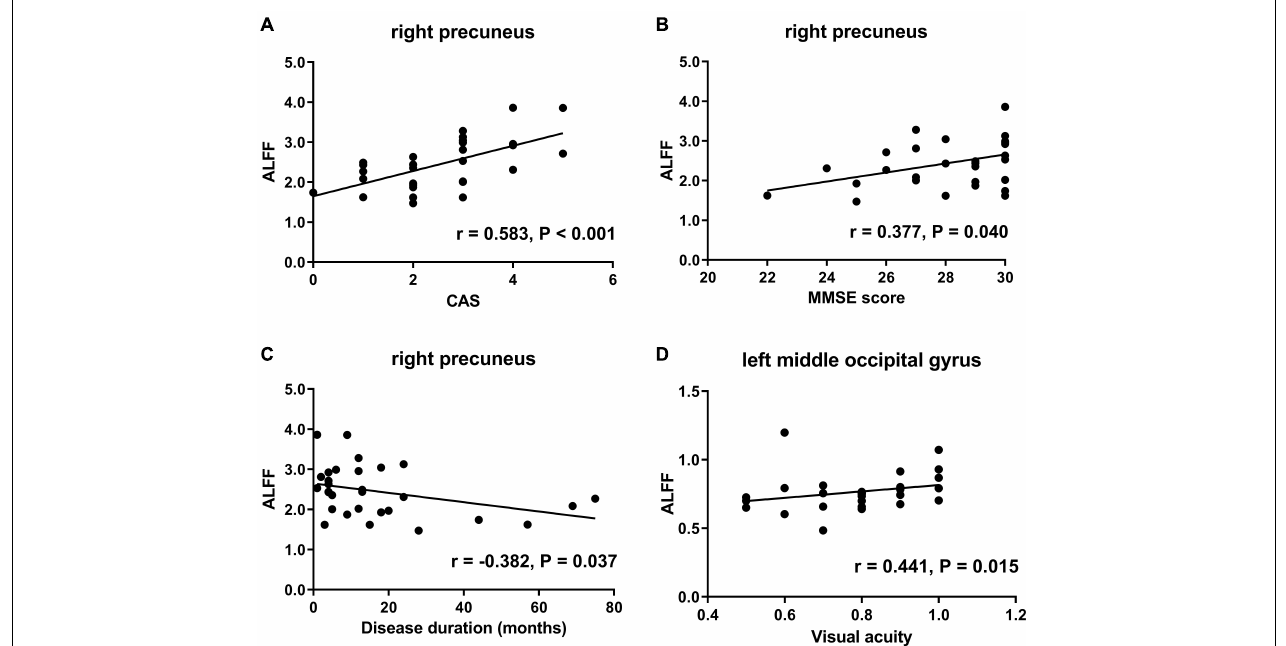
FIGURE 5 | Scatter diagrams show the significant correlations between clinical and neuropsychological assessment results and the ALFF values in TAO patients. (A) ALFF in the right precuneus was positively correlated with CAS ( r = 0.583, P < 0.001). (B) ALFF in the right precuneus was positively correlated with MMSE score ( r = 0.377, P = 0.040). (C) ALFF in the right precuneus was negatively correlated with disease duration ( r = − 0.382, P = 0.037). (D) ALFF in the left middle occipital gyrus was positively correlated with visual acuity ( r = 0.441, P = 0.015). ALFF, amplitude of low frequency fluctuation; TAO,